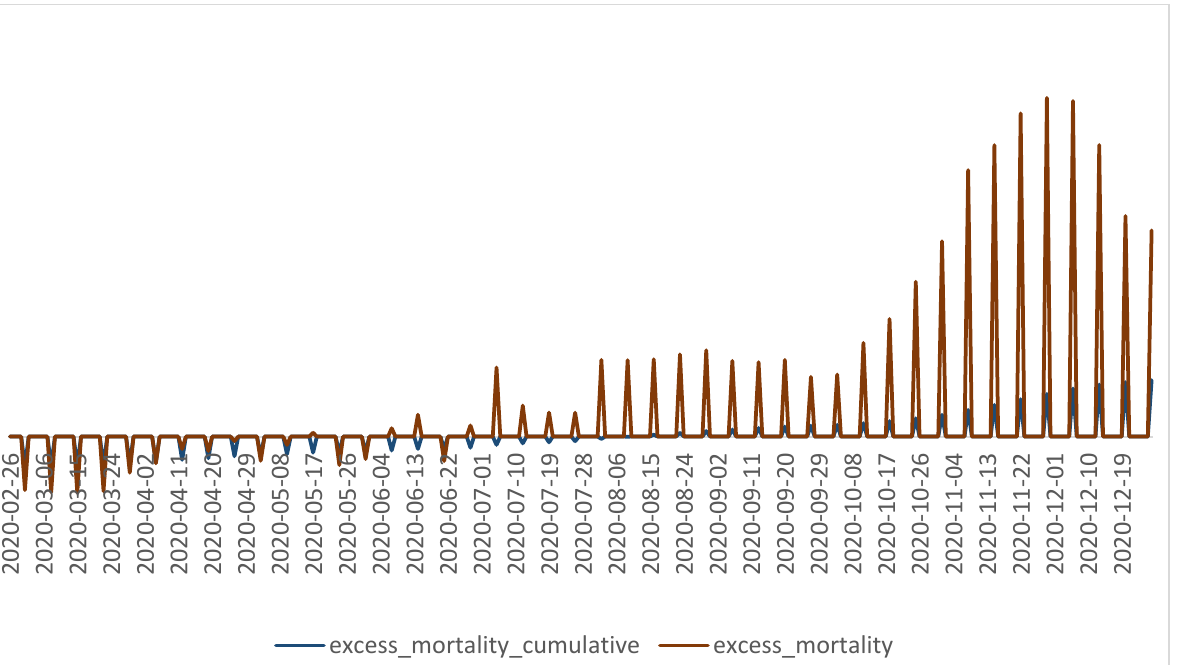
Figure 3. The evolution of the cumulative excess mortality and excess mortality indicators in Roma-